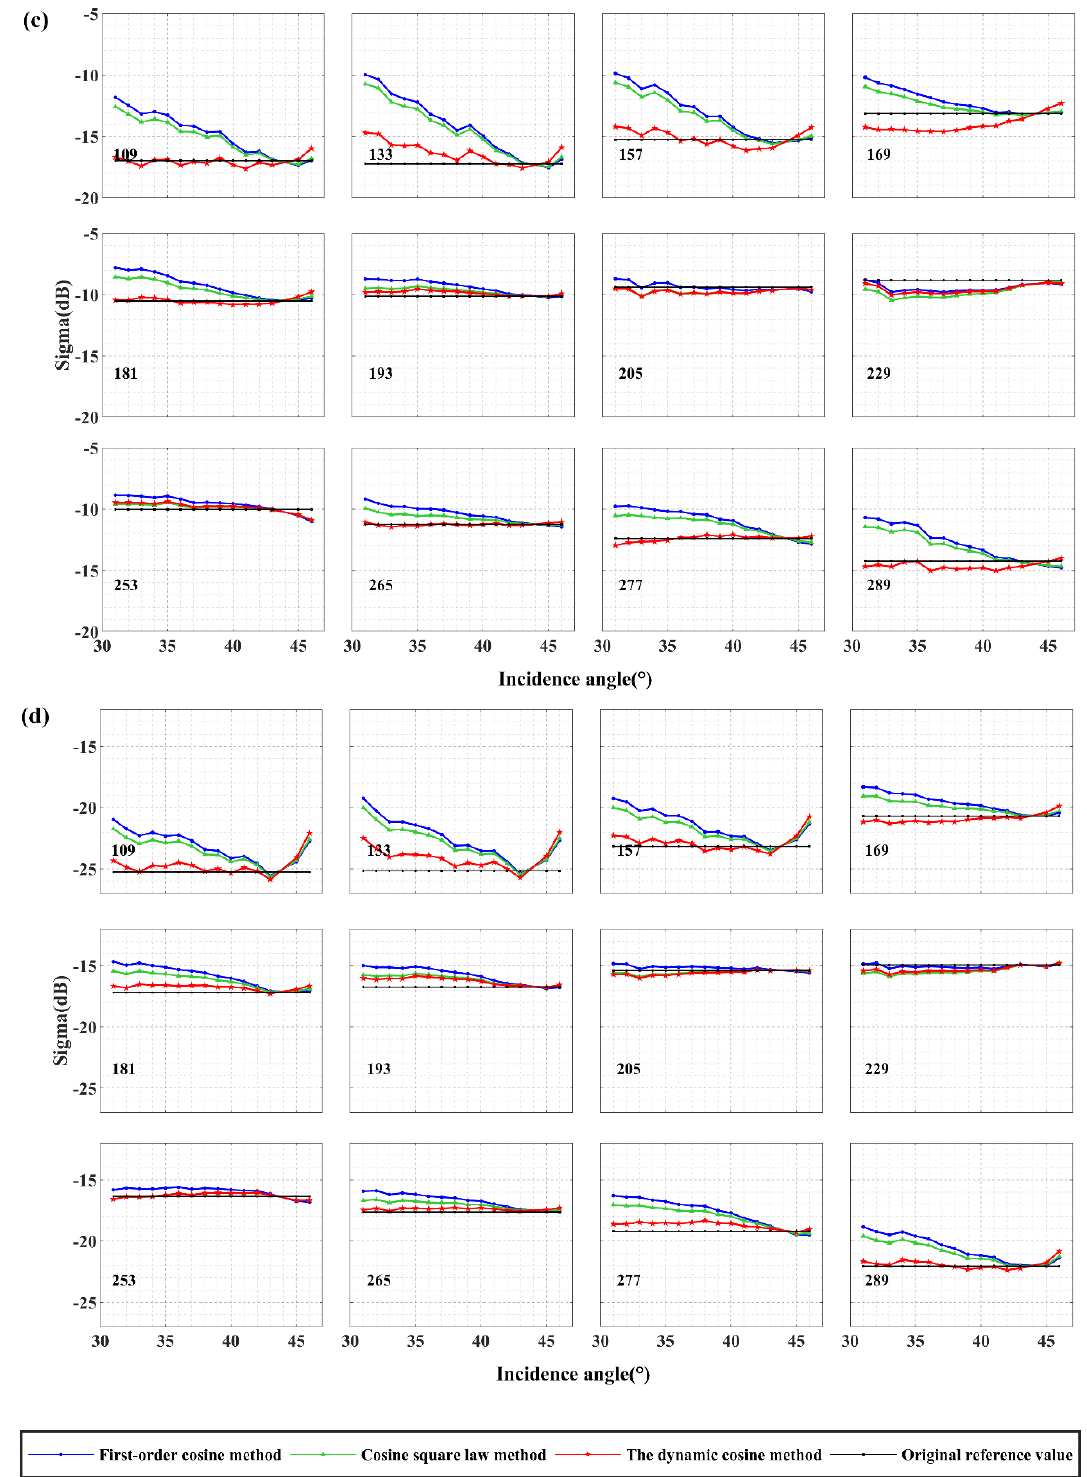
Figure A1. Comparison of three normalization algorithms from April to October. ( a ) is the normalization of VV polarization to 34 ◦ ; ( b ) is the normalization of VH polarization to 34 ◦ ; ( c ) is the normalization of VV polarization to 44 ◦ ; ( d ) is the normalization of VH polarization to 44 ◦ .